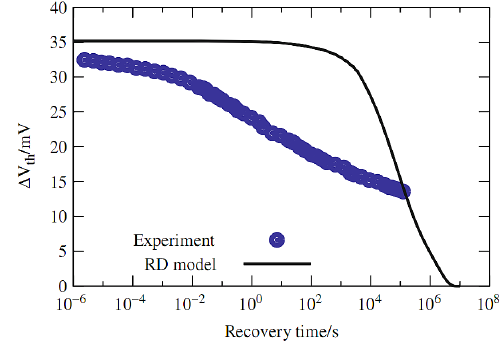
Figure 3. Recovery phase predictions according to the reaction-diffusion (RD) model and experimental data ([4], p.